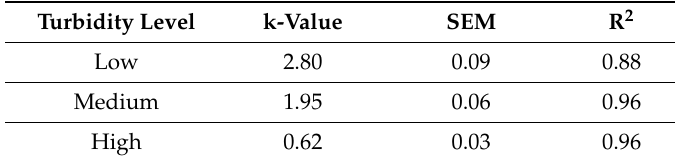
Table 2. Fitted k-values for bla CTX-M-15 -producing E. coli decay in waters of di ff erent turbidity levels over time, following exposure to UV